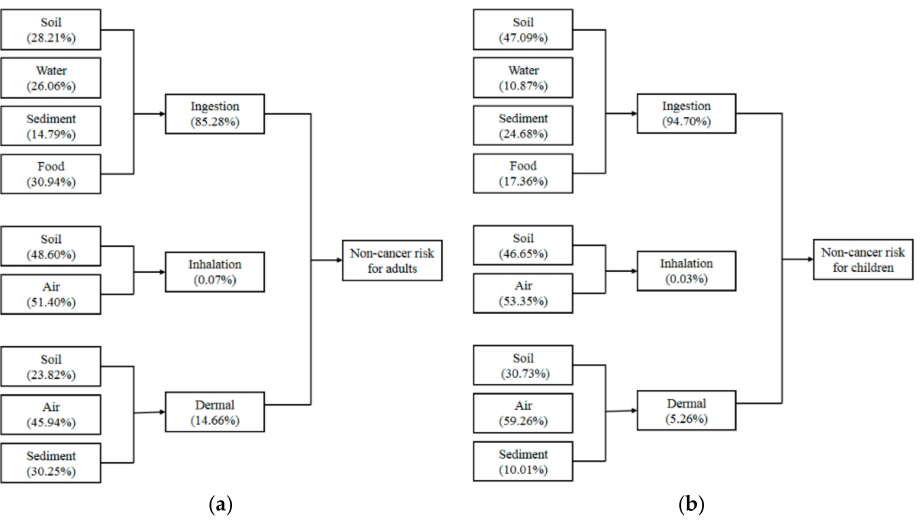
Figure 3. Multi-pathway analysis of hazard quotient (HQ). ( a ) Each pathway’s contribution to the total HQ of the local adults; ( b ) Each pathway’s contribution to the total HQ of the local children. Table 8. Carcinogenic risk of trace metals for adults and